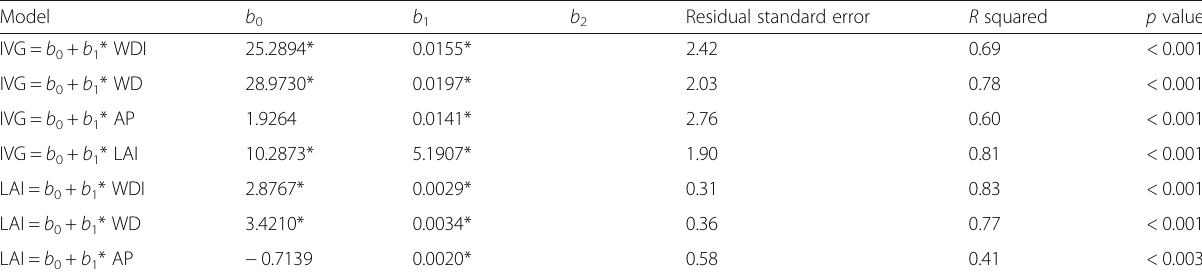
Table 4 Linear regression models between leaf area index (LAI), volume growth (IVG) and water variables, water deficit index (WDI), water deficit (WD) and precipitation (AP), in the studied sites